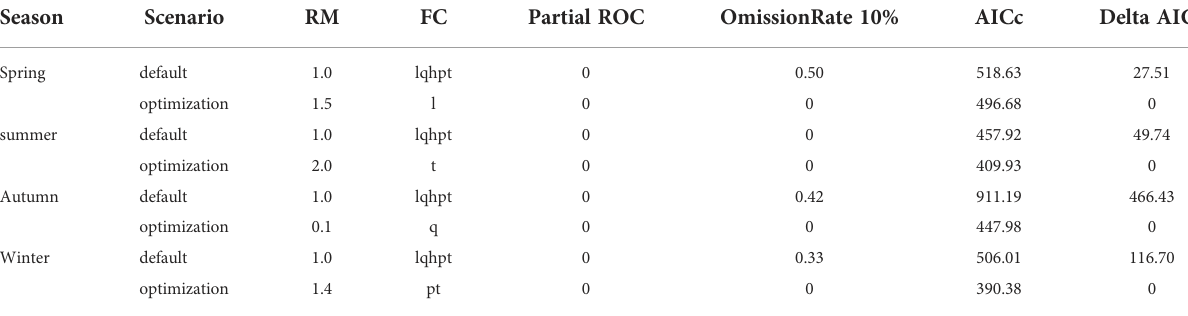
TABLE 2 MaxEnt model performance under default and optimized